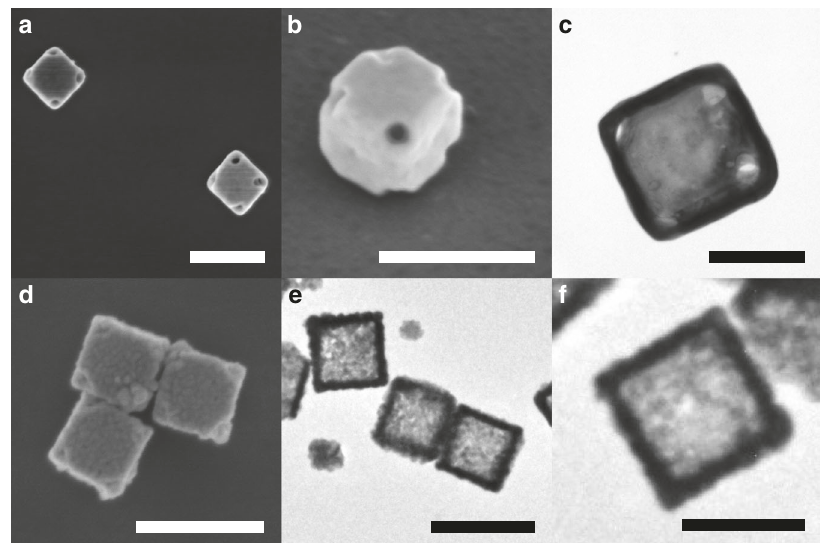
Fig. 2 SEM and TEM images of Au – Ag nanoboxes. a – c smooth and d – f rough nanoboxes. Scale bar is 200 nm in a , b , d , e and 100 nm in c , f . b was taken at a tilt angle